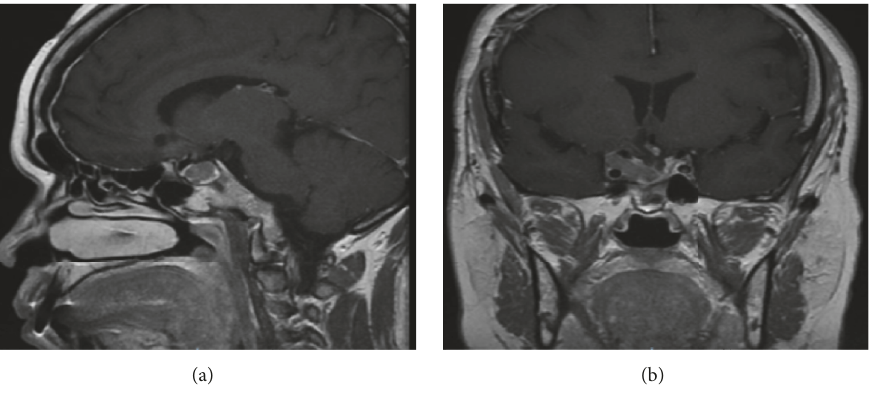
Figure 3: Sagittal and coronal MRI T1 sequences with gadolinium. Residual tumoral tissue only located intrasellar and right parasellar after second surgery.